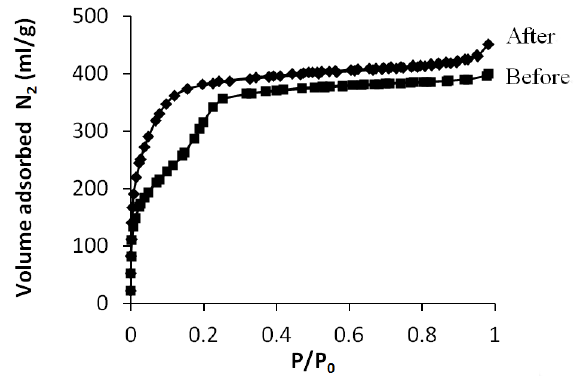
Figure 5. N sorption isotherms of MCM-41 and MCM-41 after 2